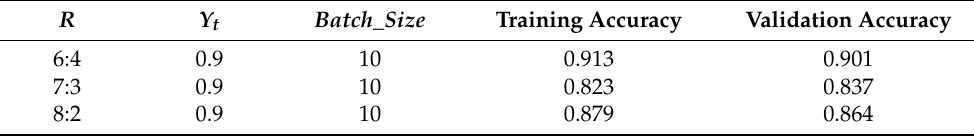
Table 2. Determination of the dataset ratio R .